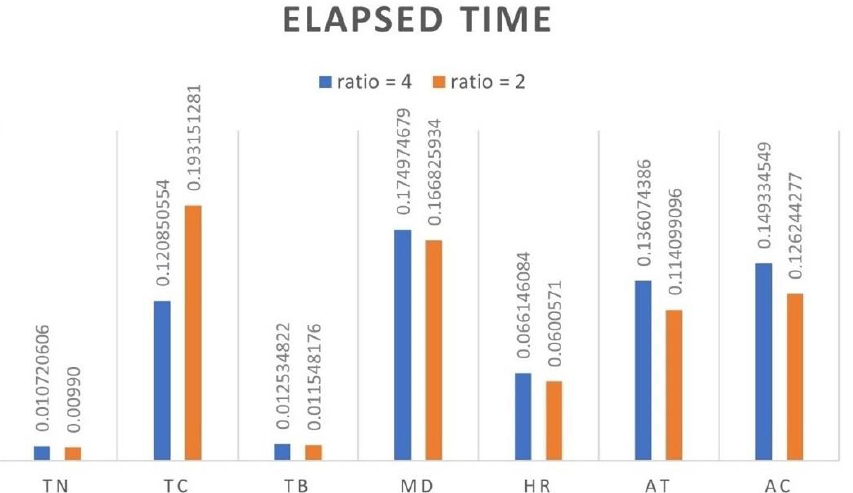
Figure 9. Average time (in seconds): traditional nearest neighbor (TN), traditional bicubic (TC), traditional bilinear (TB), normalized minimum side-based diameter-based (MD), normalized hypotenuse radius-based (HR), normalized virtual pixel length-based height for the area of the triangle-based (AT), and normalized virtual pixel length for hypotenuse-based radius for the area of the circle (AC) interpolation algorithms.